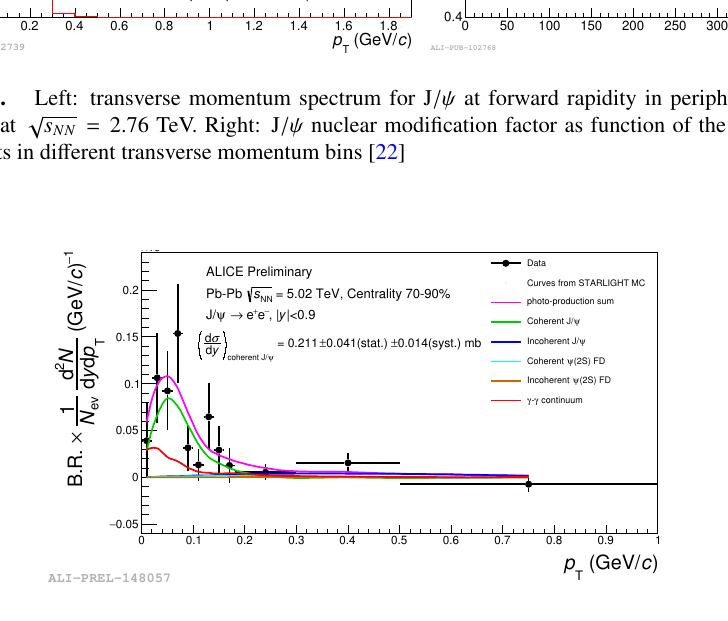
Figure 12. Transverse momentum spectrum for J /ψ at central rapidity in peripheral Pb–Pb collisions √ s NN = 5 . 02 TeV compared to several theoretical at